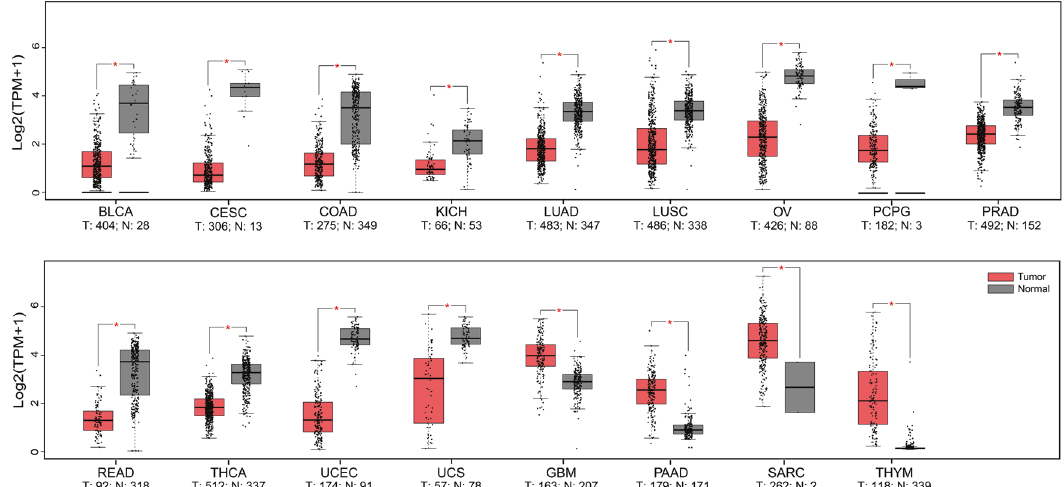
Fig. 3 The expression levels of FBXL7 between human tumor tissues and their corresponding normal tissues. The levels of FBXL7 transcripts are markedly altered in various human cancer tissues, compared to their corresponding normal controls, based on the analysis of Gene Expression Pro fi ling Interactive Analysis (GEPIA) database with tumor and normal tissue samples from The Cancer Genome Atlas (TCGA) and Genotype-Tissue Expression (GTEx) projects. The number of tumor (T) and normal (N) tissues is indicated. BLCA, bladder urothelial carcinoma; CESC, cervical squamous cell carcinoma and endocervical adenocarcinoma; COAD, colon adenocarcinoma; GBM, glioblastoma multiforme; KICH, kidney chromophobe; LUAD, lung adenocarcinoma; LUSC, lung squamous cell carcinoma; OV, ovarian serous cystadenocarcinoma; PAAD, pancreatic adenocarcinoma; PCPG, pheochromocytoma and paraganglioma; PARD, prostate adenocarcinoma; READ, rectum adenocarcinoma; SARC, sarcoma; THCA, thyroid carcinoma; THYM, thymoma; UCEC, uterine corpus endometrial carcinoma; UCS, uterine carcinosarcoma. TPM: transcripts per million; * p < 0.05, one-way